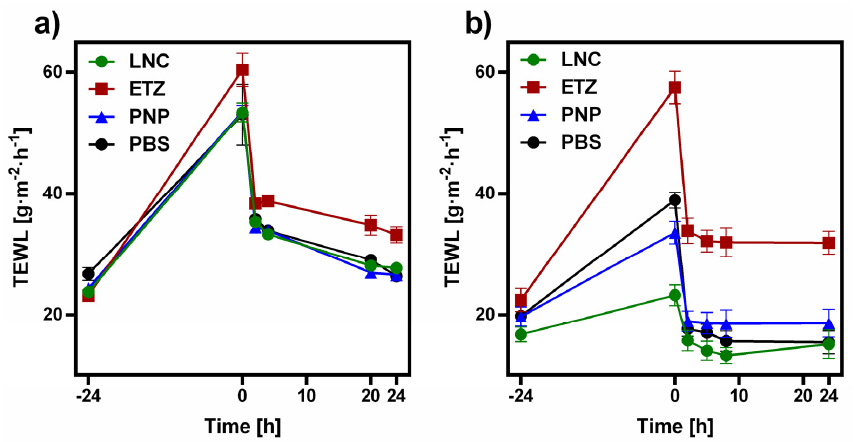
Figure 8. Development of trans-epidermal water loss values of untreated and formulation-treated ( a ) porcine skin, ( b ) human skin. The formulation was applied on the skin between − 24 and 0 h of the experiment. n ≥ 3.